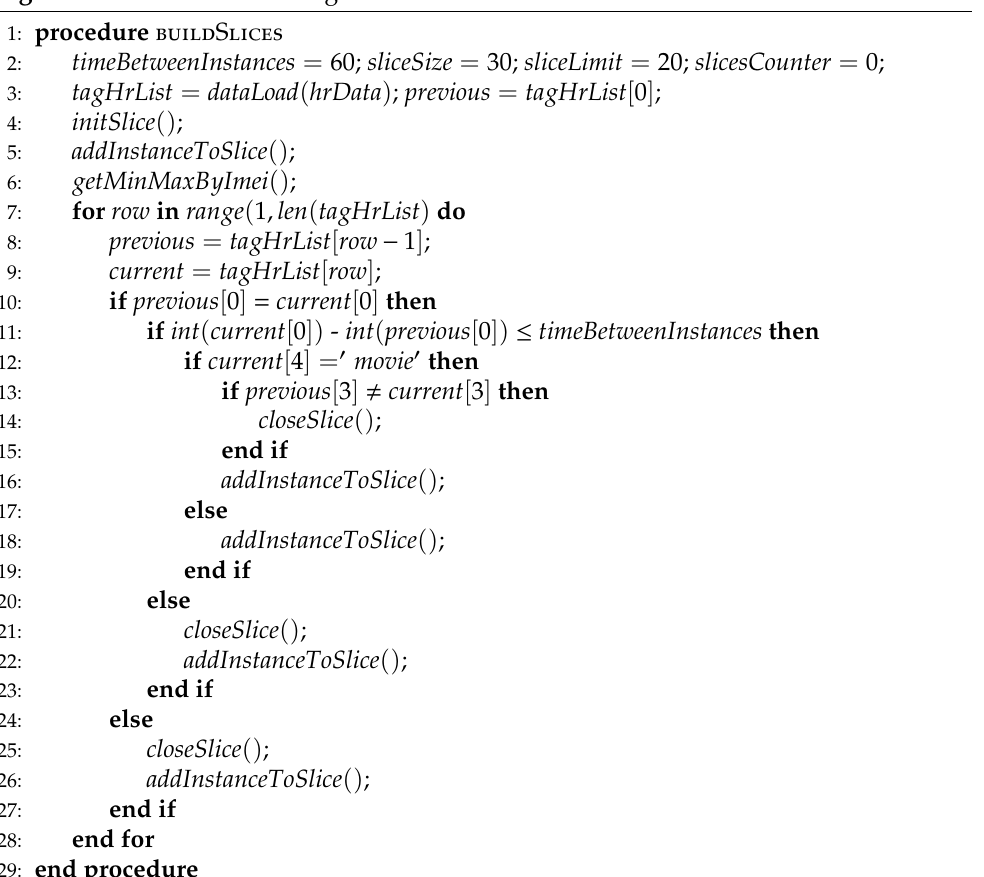
Algorithm 2. Emotional